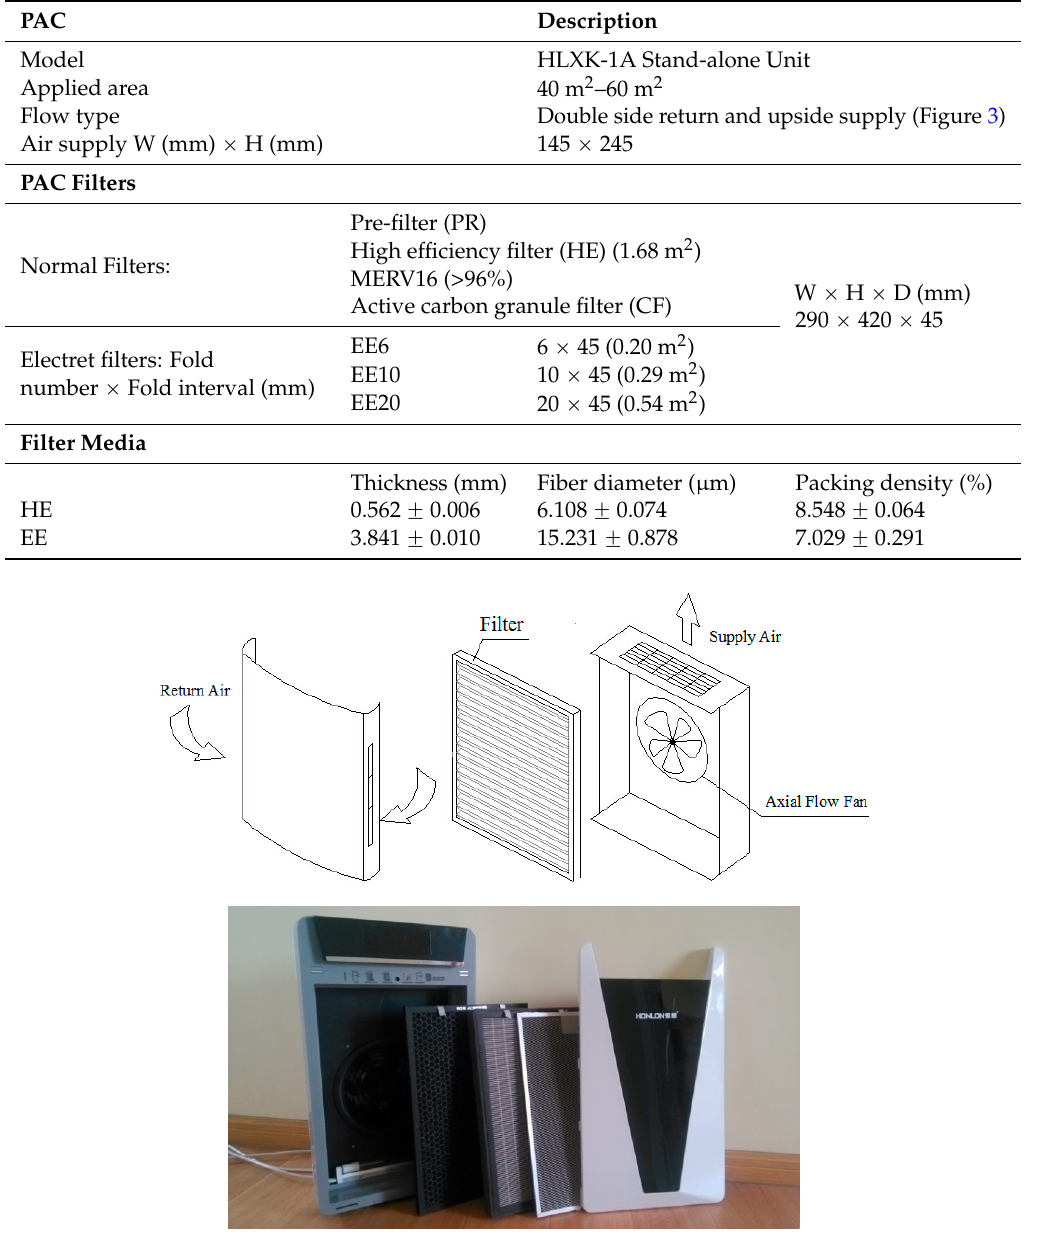
Figure 3. Schematic diagram of the portable air cleaner.